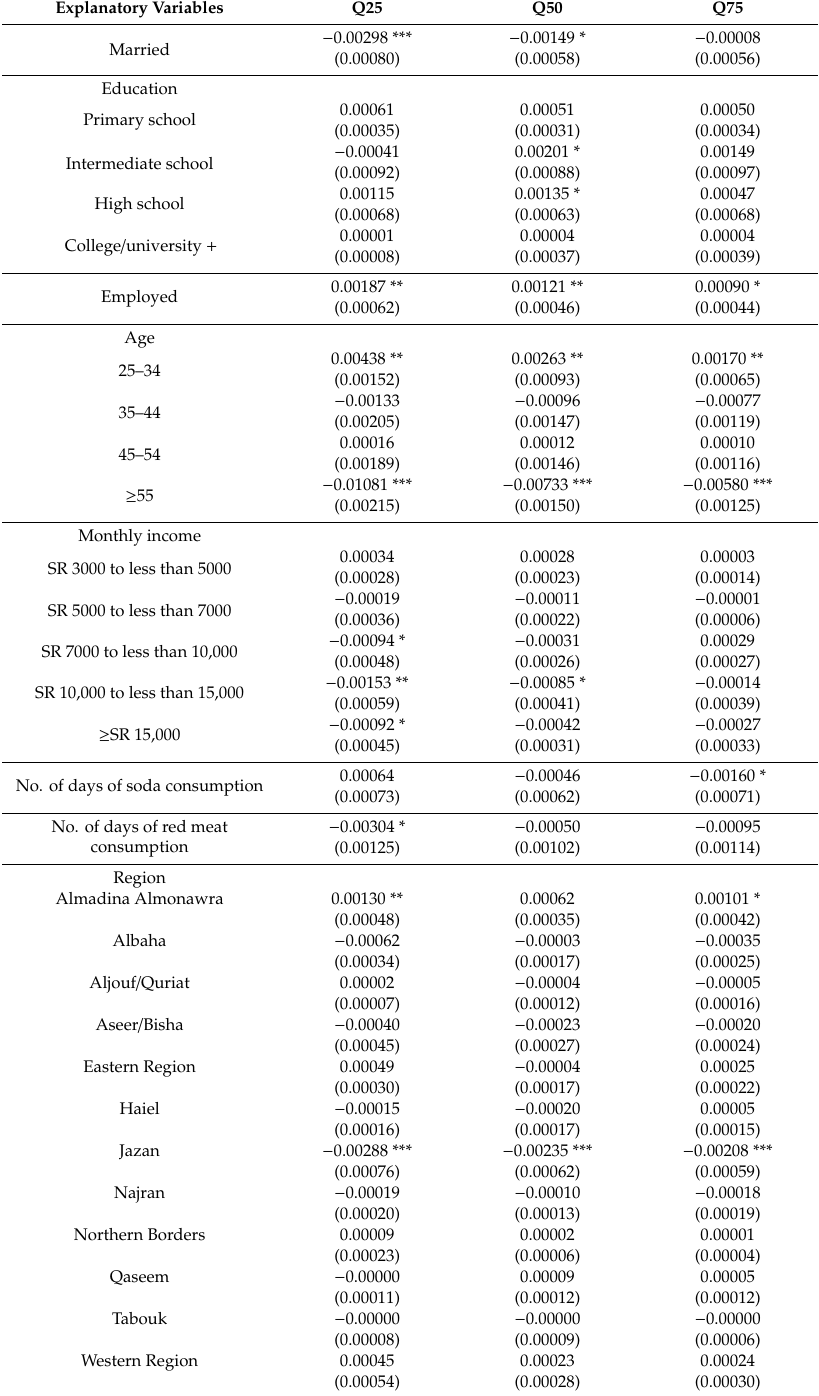
Table 4. Detailed decomposition of explained covariate e ff ect across distribution. Results from the 2013 Saudi Health Interview Survey